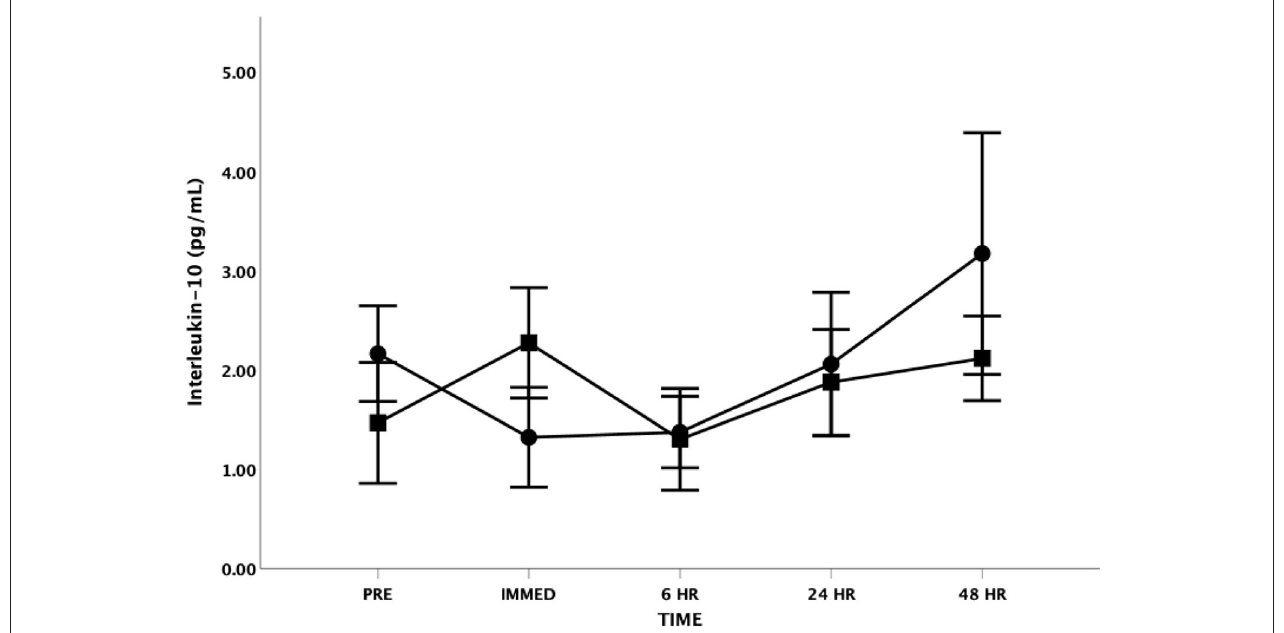
FIGURE 4 | Interleukin-10 (IL-10) as a function of time. Means ± SD. Circle = Steady State; Square = Interval. Error Bars = ± SEM.